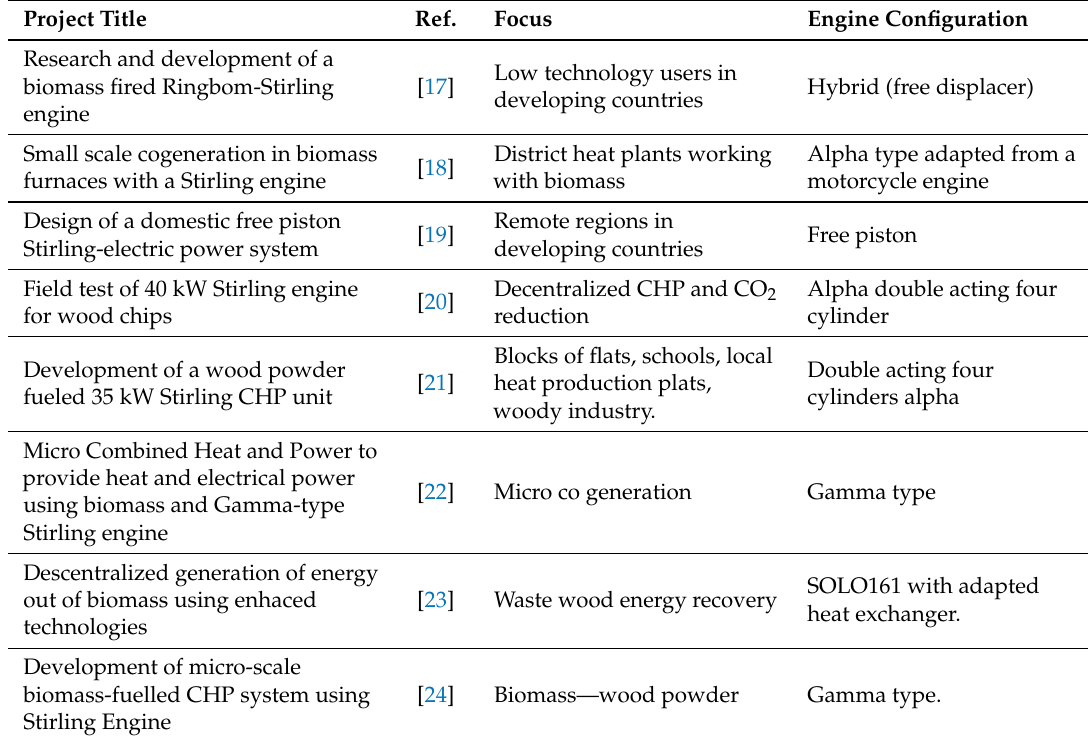
Table 1. Different configurations are applied to meet similar